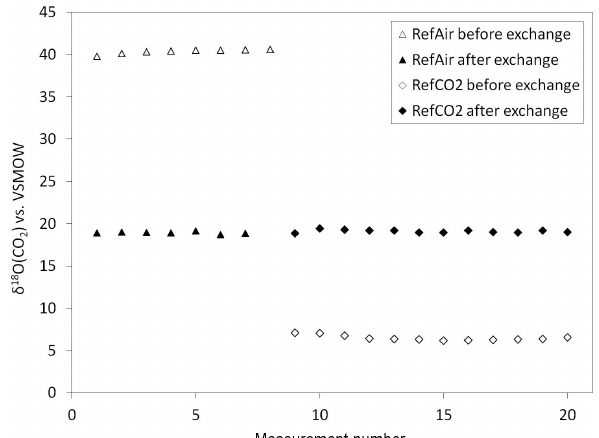
Figure 7. Efficiency of oxygen isotope equilibration in the CuO oven. The δ 18 O(CO 2 ) values of RefAir and a mixture of RefCO 2 in synthetic air are shown before and after isotope equilibration. The last point of the RefAir measurement sequence after exchange is missing because the peak of the last run was accidentally not